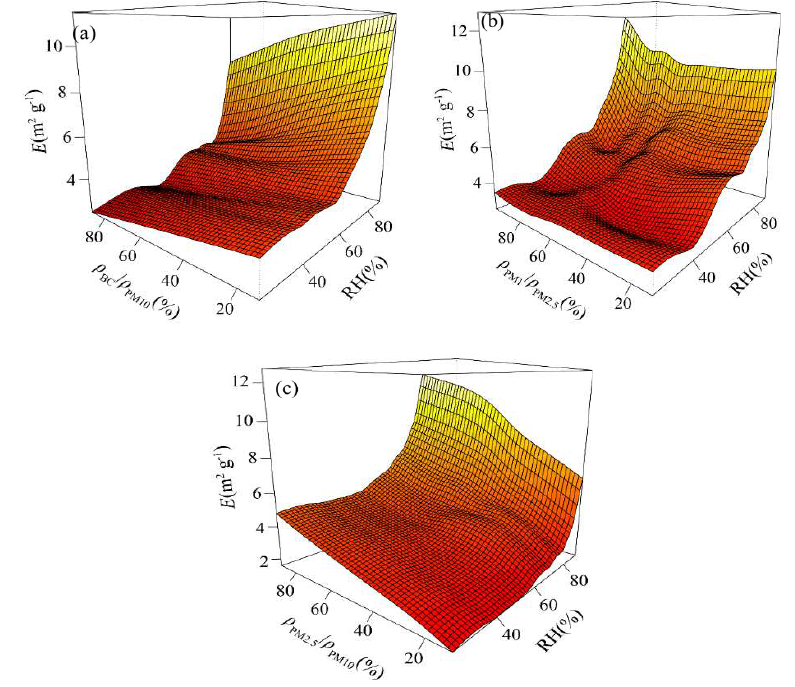
Figure 9. Three-dimensional graphs for the influence of the interaction between the RH and aerosol components on the change of aerosol extinction coefficient per unit of mass. ( a – c ) represent the RH- ρ BC / ρ PM10 , RH- ρ PM1 / ρ PM2.5 and RH- ρ PM2.5 / ρ PM10 , respectively.